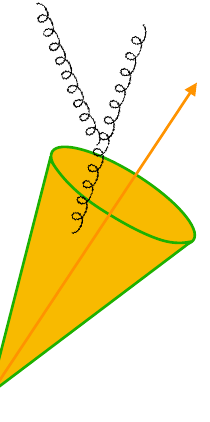
Figure 2 . Illustration of first non-global logarithms from quantum correlation of in-jet and out-of- jet